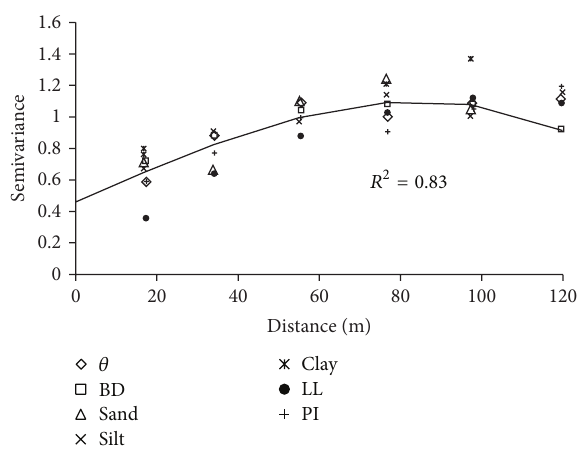
Figure 8: Scaled semivariogram and adjusted spherical model to BD, 𝜃 , sand, silt, clay, LL, and